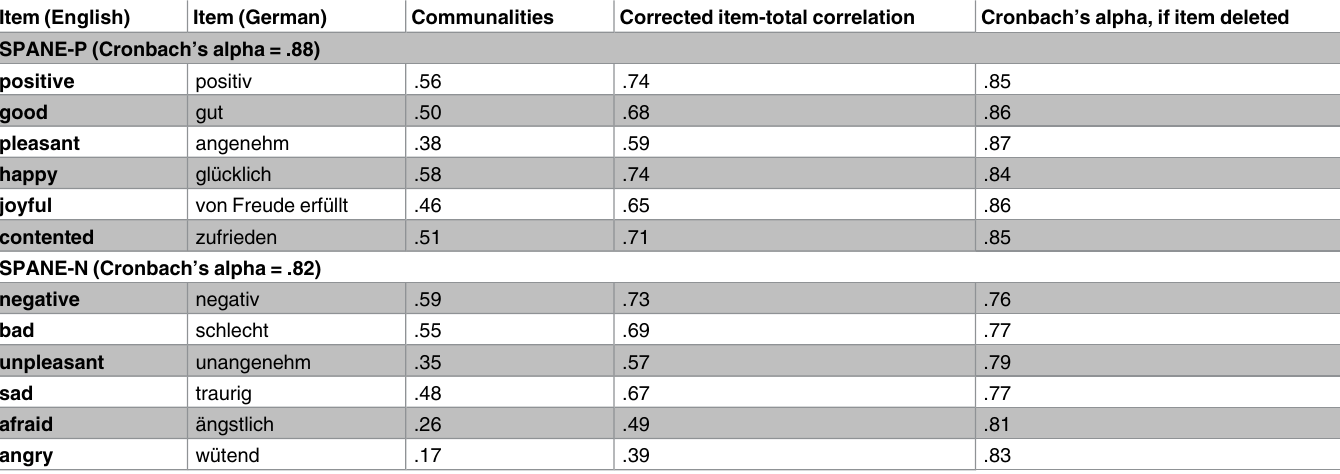
Table 3. Item communalities and variation in internal